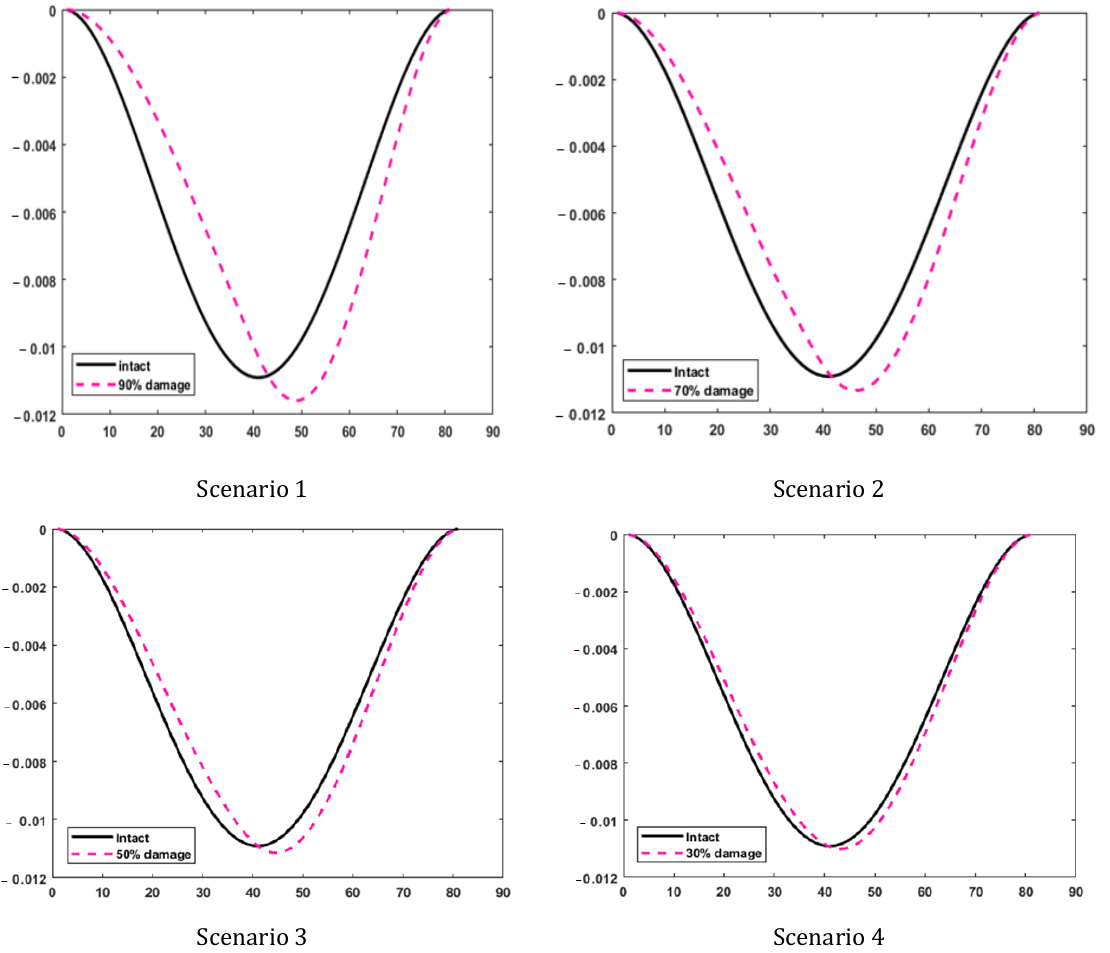
Figure 4. Differences in intact and damaged modes for four considered damage scenarios.